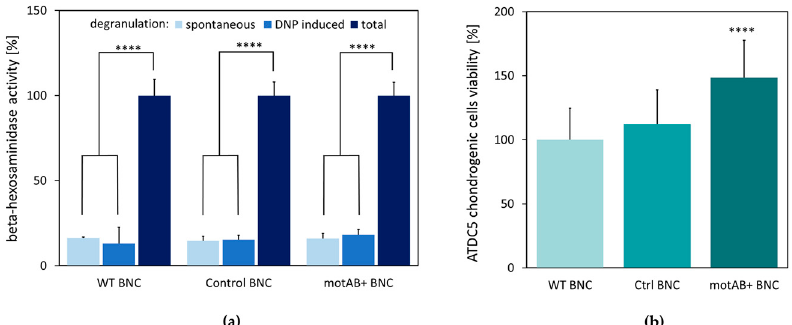
Figure 4. Verification of modified BNC material safety in in vitro experiments. ( a ) Measurement of mast cells degranulation with β -hexosaminidase activity assay. Dark blue—a positive control—cells treated with Triton X-100; blue—degranulation induced by addition of DNP, pale blue—spontaneous degranulation observed with no additives Statistics: **** denotes p < 0.0001 when compared to positive control; ( b ) Viability of ATDC5 cells growing on mutant-derived BNC material vs cells cultured on unmodified BNC (WT), whose viability was assumed to be 100% measured by PrestoBlue assay after 14 days of incubation. Data represent the means ± SD; Statistics: **** denotes p < 0.0001 when compared to wild type